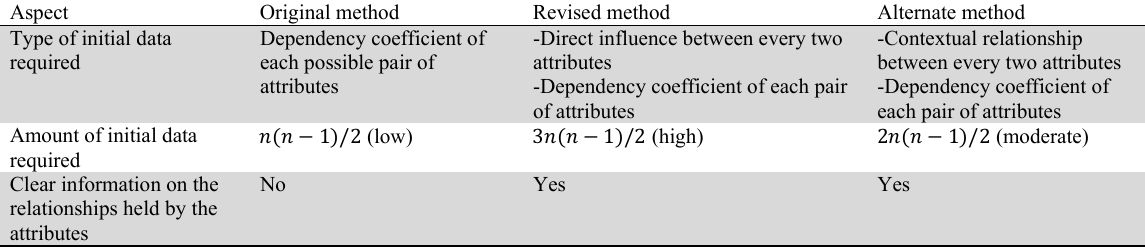
Fig. 4 Initial data requirement among the three versions of identification methods Table 17 recaps the differences between the available (cid:2019) (cid:2868) -measure identification methods as discussed in this section. Comparison of the (cid:2019) (cid:2868) -measure identification